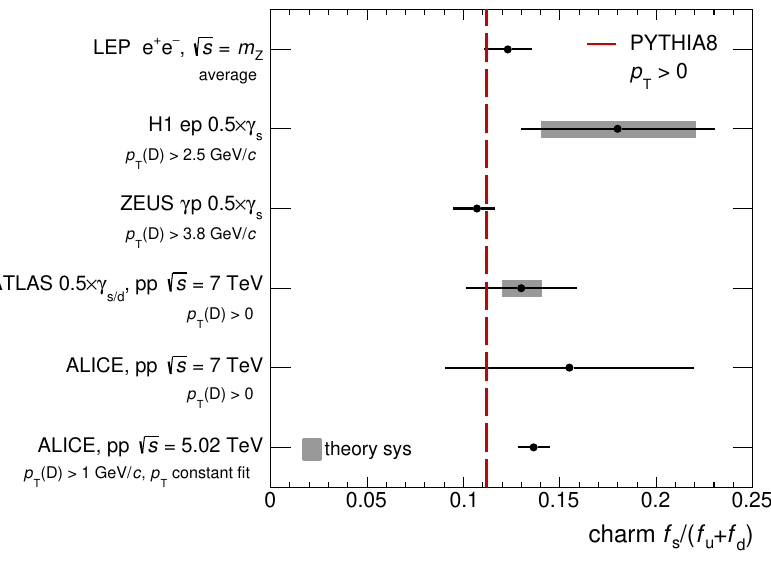
Figure 10 . Charm-quark fragmentation-fraction ratio f s / ( f u + f d ) compared with previous mea- surements performed by the ALICE [5], H1 [90], ZEUS [91], and ATLAS [18] Collaborations and to the average of LEP measurements [83]. The total experimental uncertainties (bars) and the theoretical uncertainties (shaded boxes) are shown. The experimental measurements are compared to the value obtained from PYTHIA 8 simulations with Monash-13 tune